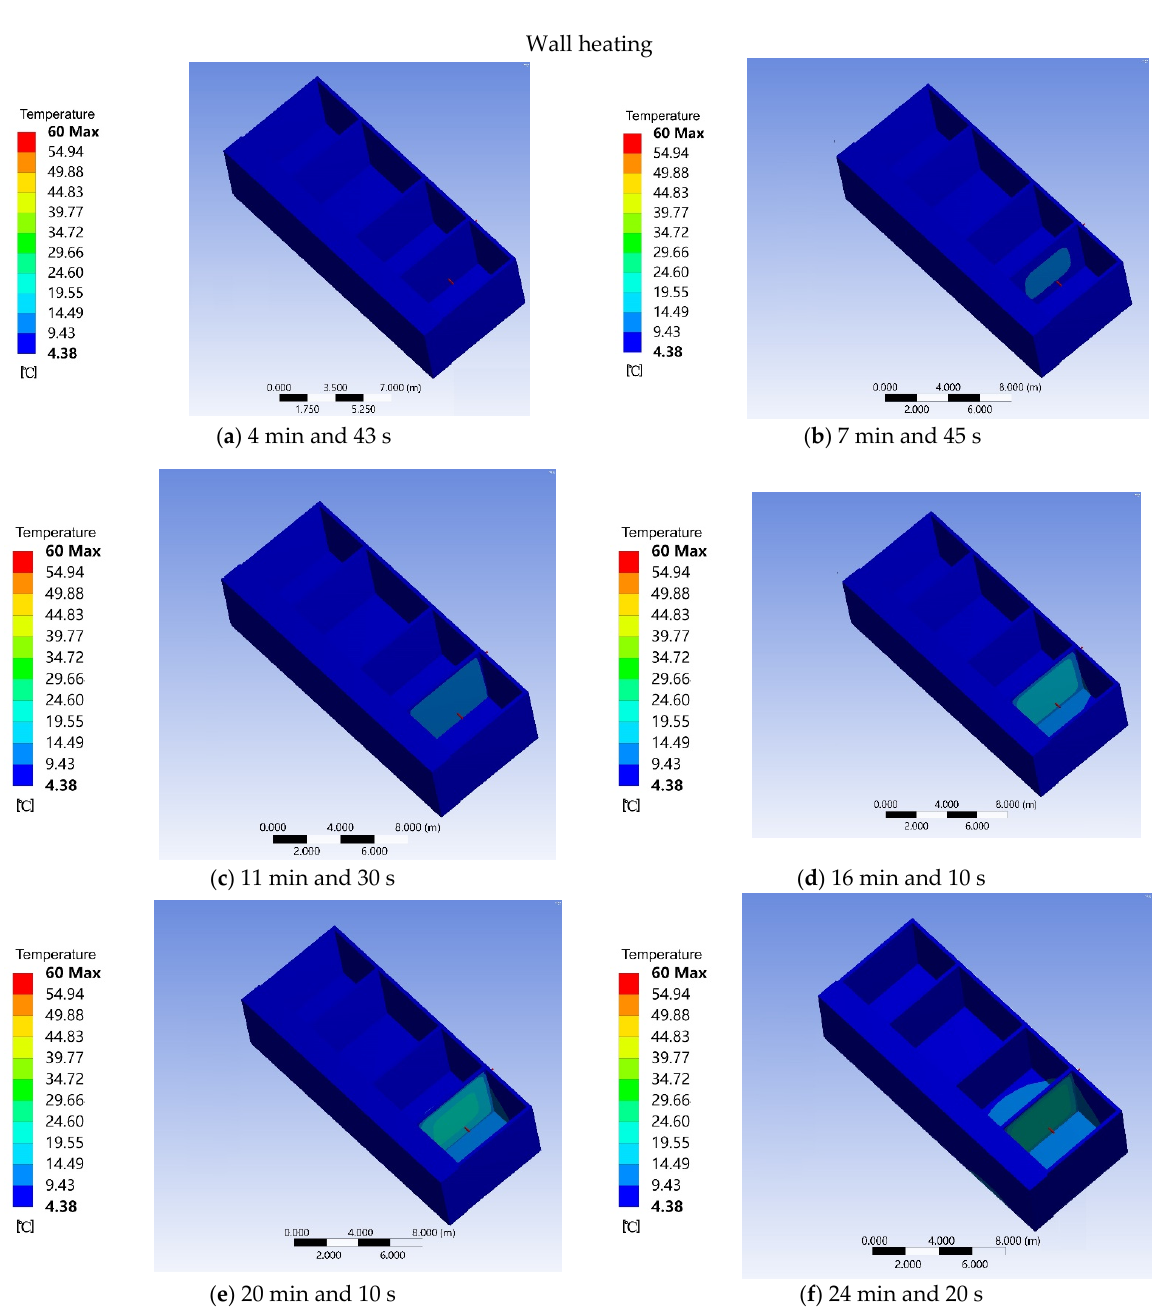
Figure 11 . ( a ) Wall heating in 4 min and 43 s. ( b ) Wall heating in 7 min and 45 s. ( c ) Wall heating in 11 min and 30 s. ( d ) Wall heating in 16 min and 10 s. ( e ) Wall heating in 20 min and 10 s. ( f ) Wall heating in 24 min and 20 s. Through the investigation of the duration of cooking in winter, a single cooking event took 60 min, where the initial firewall heating time was 26 min and 25 s, and the remaining started at 9:00 a.m., and the initial temperature was also 5 °C. Under the condition of solar